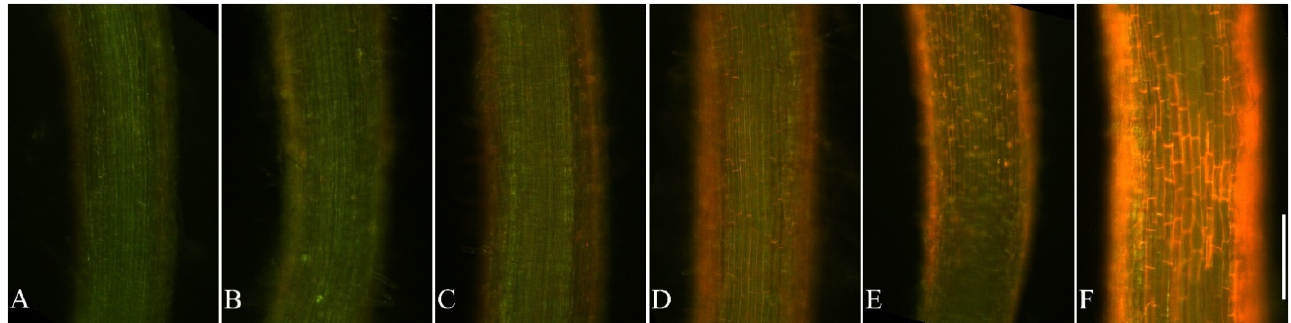
Figure 5. Relative Evans blue uptake of lettuce seedlings after treatments with acacetin. The results presented are mean of three replicates ± SE, different letters denote significant differences at p < 0.05 according to one-way ANOVA with an LSD test.